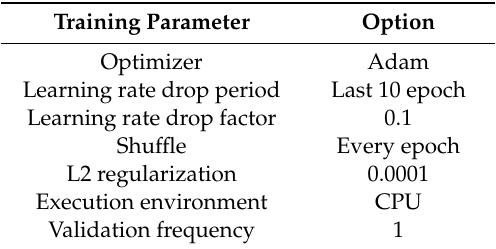
Table 8. Fixed training parameters and their options.